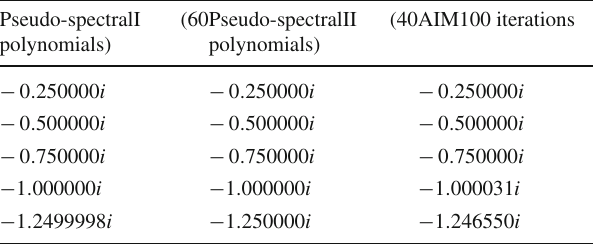
Table 5 Purely imaginary frequencies for spin 1 / 2 perturbations nor- malized by the mass ( M ω) . The numerical values of such